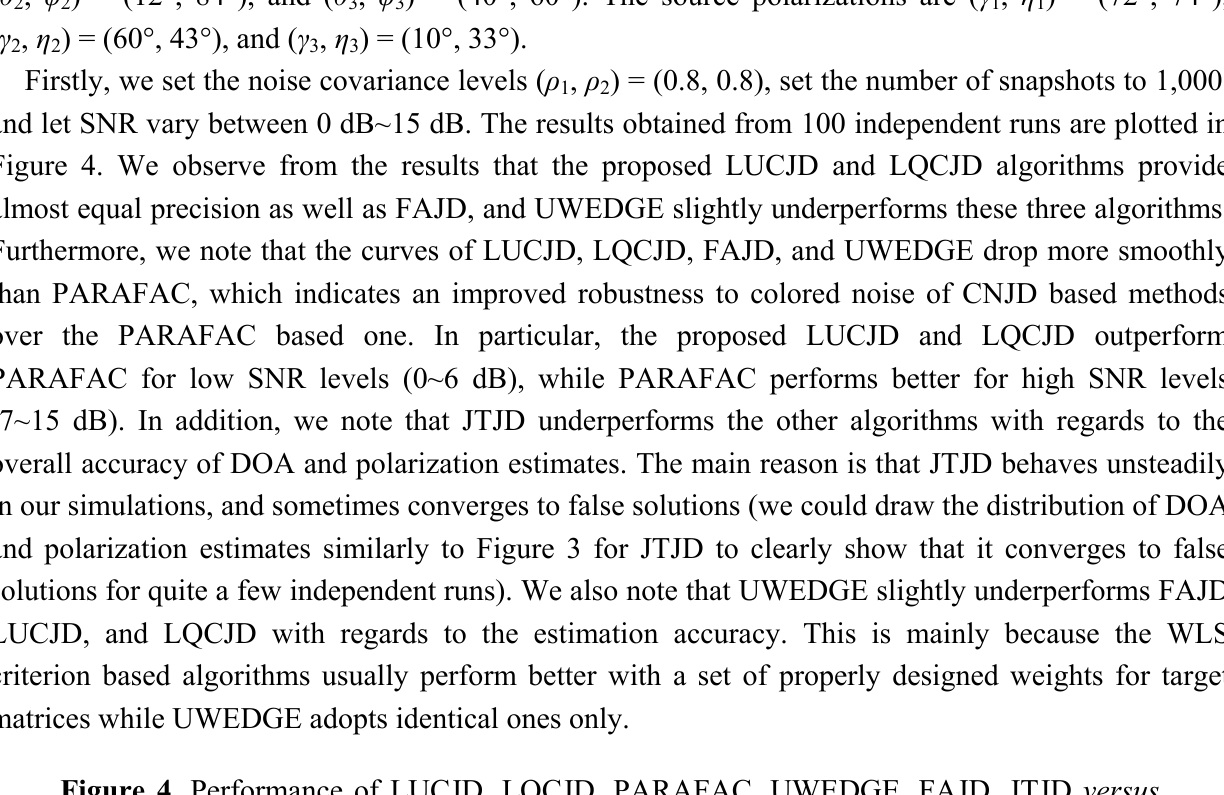
Figure 4. Performance of LUCJD, LQCJD, PARAFAC, UWEDGE, FAJD, JTJD versus SNR. The number of snapshots is 1,000, and the noise is with covariance levels , ρ ) = (0.8, 0.8). ( a ) The overall RMSAE curves of DOA estimates. ( b ) The overall ( ρ 1 2 RMSE curves of polarization amplitude angle estimates. ( c ) The overall RMSE curves of polarization phase difference angle